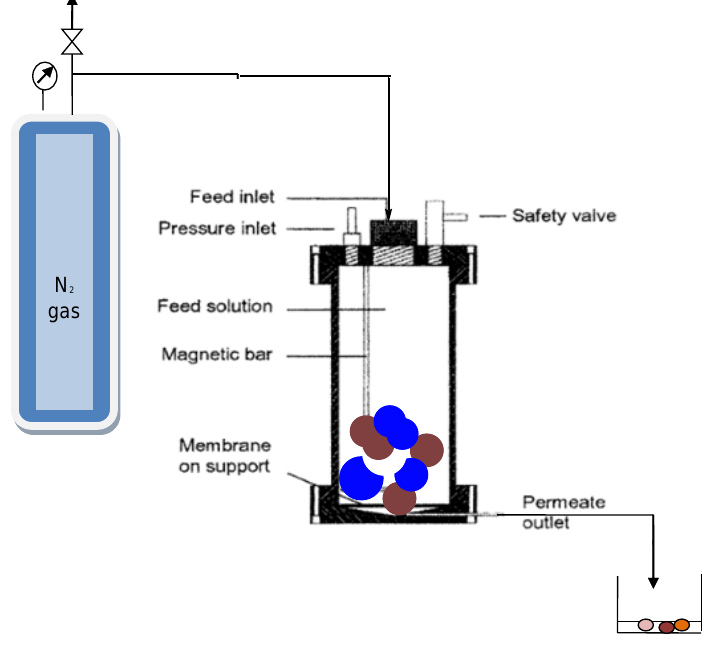
Figure 2. Dead-end unit module used for this